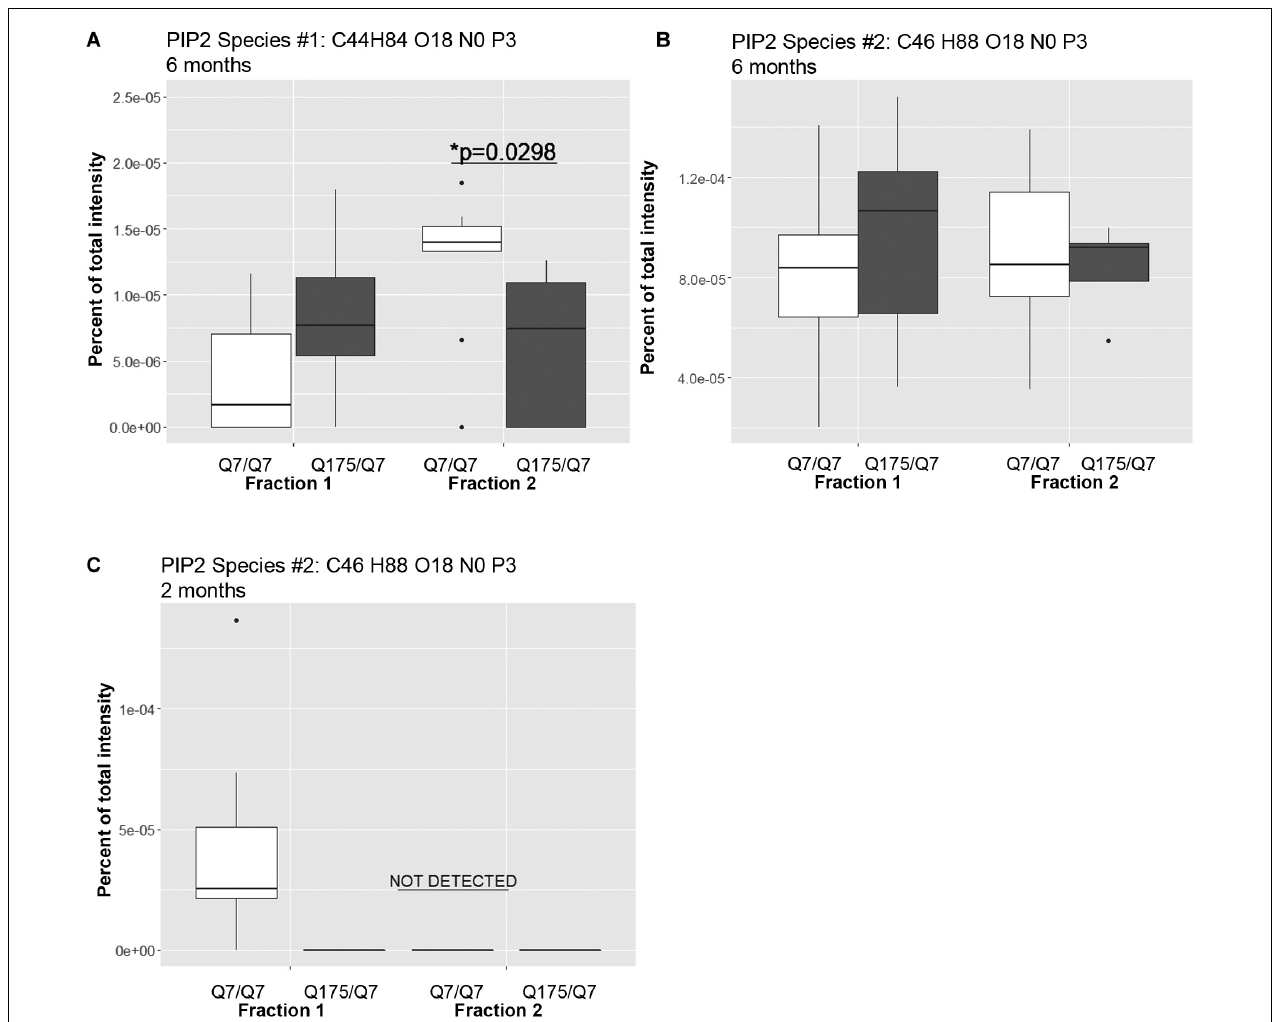
FIGURE 4 | Levels of PIP2 species detected by LC-MS/MS in fractions 1 and 2 of continuous density gradients of fractionated Q175/Q7 and Q7/Q7 striata. Graphs show Tukey-style box plots where the lower and upper hinges correspond to the first and third quartiles (the 25th and 75th percentiles) as described in section “Materials and Methods.” Data beyond the end of the whiskers are called “outlying” points and are plotted individually. Outliers were not removed from statistical analysis. NOT DETECTED, indicates species was not detected using the modified 80% rule (Yang et al., 2015). (A,B) Levels of the two PIP2 species detected at 6 months in fractions 1 and 2. In (A) , there was a significant increase in PIP2 species #1 (C44 H84 O18 N0 P3) in fraction 2 between Q7/Q7 and Q175/Q7 ( ∗ p < 0.05, unpaired t -test, N = 9 per group), whereas there was no significant difference in the second species in either fraction between genotypes (B) . (C) Levels